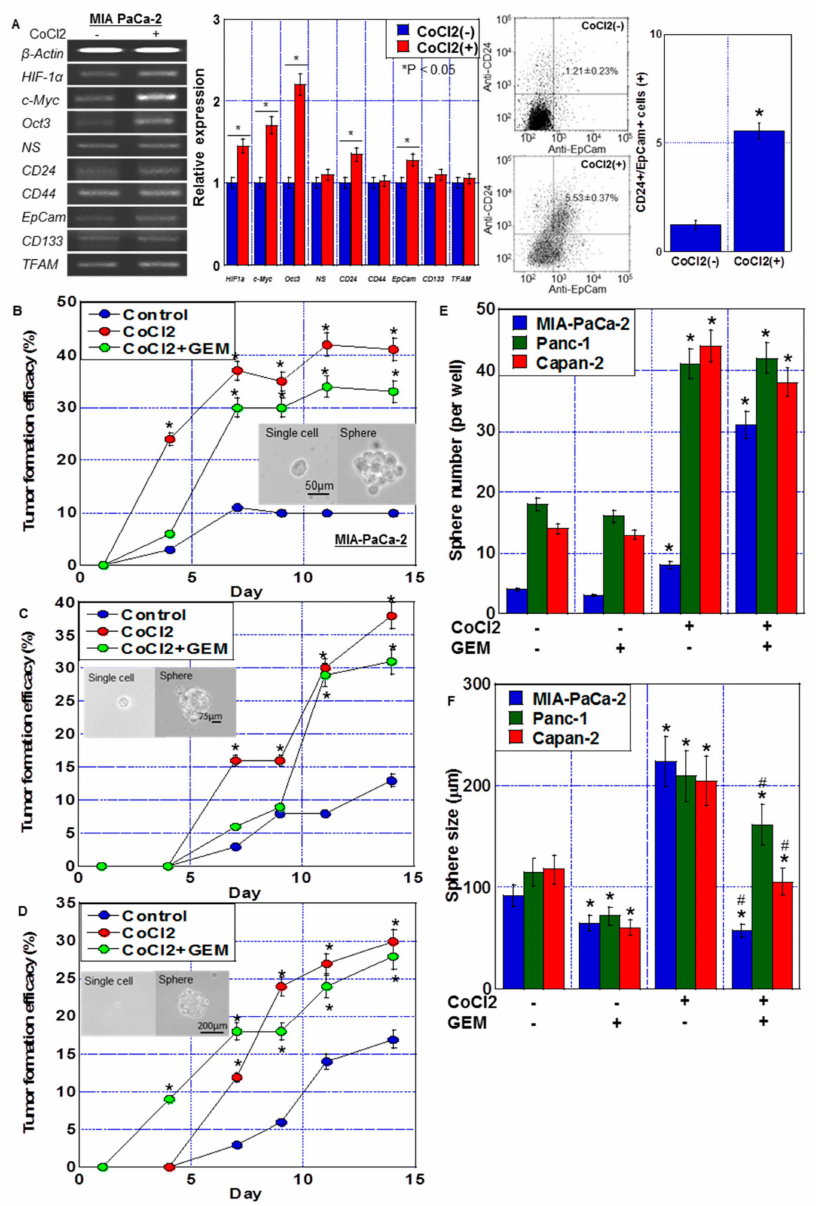
Figure 2. Stemness induced by CoCl 2 in MIA-PaCa-2 PDA cells. ( A ) Effect of CoCl 2 (150 µ M, 72 h) on mRNA expression of HIF-1 α and stem cell markers ( c-Myc , Oct3 , NS , CD24 , CD44 , EpCam, CD133 , and TFAM ) in MIA-PaCa-2. β -Actin was amplified for loading standard. (Middle) Semi- quantification of mRNA expression. (Right) Flow cytometric analysis of CD24+/EpCam+ cells. ( B – D ) Effect of CoCl 2 and/or GEM on stemness assessed by single-cell sphere formation efficiency in MIA-PaCa-2 ( B ), Panc-1 ( C ) and Capan-1 ( D ). Single adherent cells were seeded in a 96-well plate. Cells were treated with or without CoCl 2 (150 µ M) and GEM (0.1 µ M) for 72 h. (Insert) Phase- contrast images of single cell and sphere. Scale bar, 50 µ m. ( E , F ) Effect of CoCl 2 and/or GEM on stemness assessed by secondary sphere assay in MIA-PaCa-2, Panc-1 and Capan-1. ( E ) Sphere number. ( F ) Sphere size. Error bars represent the standard deviations from three independent examinations. * p < 0.05. (B–D) vs. Control. ( E , F ) vs. CoCl 2 (-)/GEM(-). # p < 0.05. ( F ) vs. CoCl 2 . Statistical differences were calculated by ordinary analysis of variance. GEM, gemcitabine; PDA, pancreatic ductal adenocarcinoma; NS, nucleostemin; HIF, hypoxia-inducing factor; EpCam, epithelial cell adhesion molecule; TFAM, transcription factor A